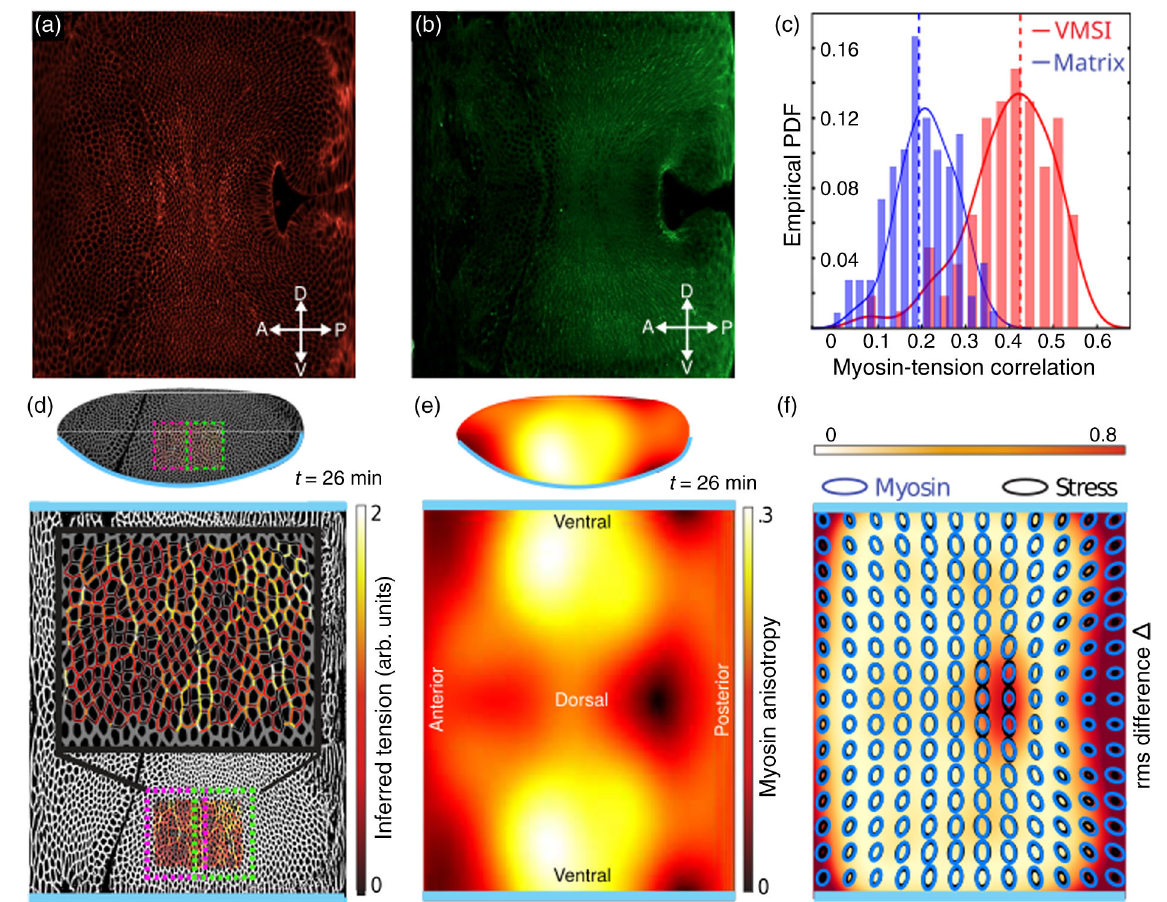
FIG. 4. Stress inference results compared to measured myosin distribution for the germ-band extension in Drosophila embryo. (a),(b) Raw in toto images showing fluorescent-labeled membrane [mCherry, shown in (a)] and myosin [Sqh-GFP, shown in (b)] obtained using light sheet microscopy and unrolled into the plane using I m S a N e [47]. Time corresponds to roughly 26 min after cephalic furrow (CF) formation. (c) The correlation between myosin and inferred tensions comparing the matrix-inverse-based method defined in Ref. [29] and the VMSI algorithm during the first 40 min of GBE. (d) An example of force inference, combining two overlapping image frames used for the analysis, shown directly on the embryo and on a cylindrical projection with the ventral line cut and mapped onto the top and bottom edges of the image with the dorsal side along the midline. Inset: Color-coded relative edge tension (in arbitrary units, arb. units) inferred by the VMSI algorithm. The inferred mechanics displays stress cables as expected for the lateral region of the embryo at the time considered. (e) The mesoscopic anisotropy of myosin, 26 min post CF formation, shown on the embryo and its cylindrical projection. Anisotropy is largest in the lateral region. The principal axis of myosin in this region points along the DVaxis. (f) The spatial distribution of the normalized rms difference [ Δ ð r Þ ] between the VMSI inferred stress tensor and the measured total myosin tensor (at 26 min post CF). Both tensor fields are represented as ellipses for direct comparison. The large discrepancy ( Δ ∼ 0 . 8 ) found in the vicinity of the anterior and posterior poles (mapped to the left and right edges of the cylindrical projection) is due to the poor imaging of the poles. The large discrepancy in the center of the dorsal region is real and can be explained by the difference between the total and “ balanced ” myosin distributions as explained in the